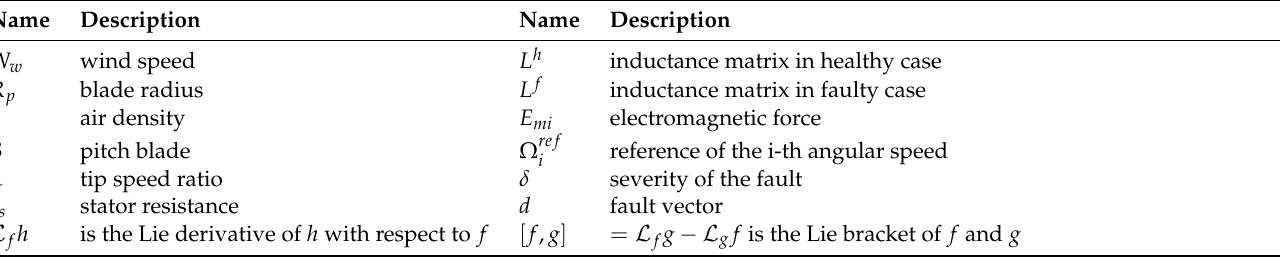
Table 1. Principal